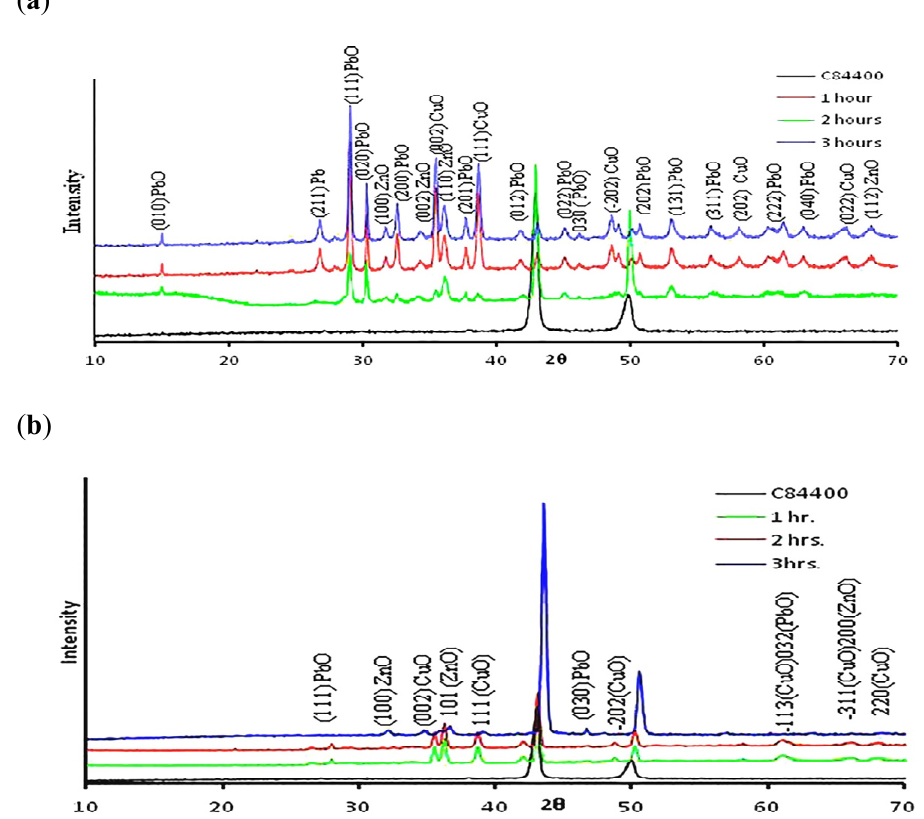
Figure 4. ( a ) X-ray diffraction pattern of thermally oxidized C84400 copper alloy samples -0.75 wt.% O ; ( b ) X-ray diffraction pattern of thermally oxidized C84400 copper in N 2 2 alloy samples in N -5 wt.% O 2 2